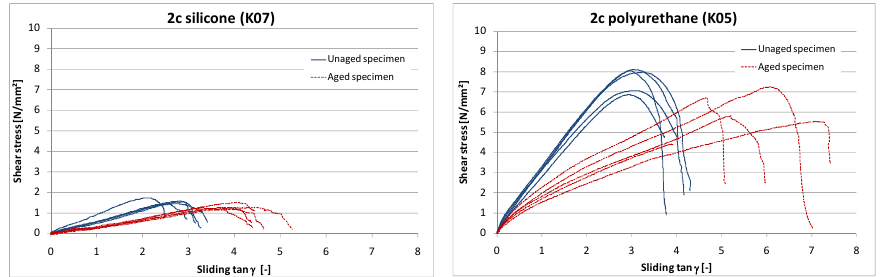
Figure 4: Comparison of the shear stress – sliding behaviour before (blue) and after (red dashed) ageing of a traditional two-component silicone (K07) and a effective two-component polyurethane